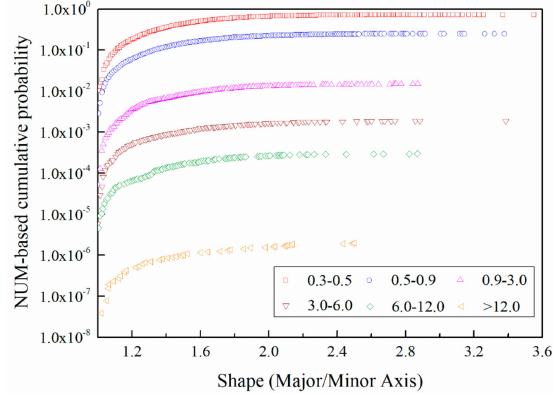
Figure 11. NUM-based cumulative probability for the shape of coal fragments at different sizes.